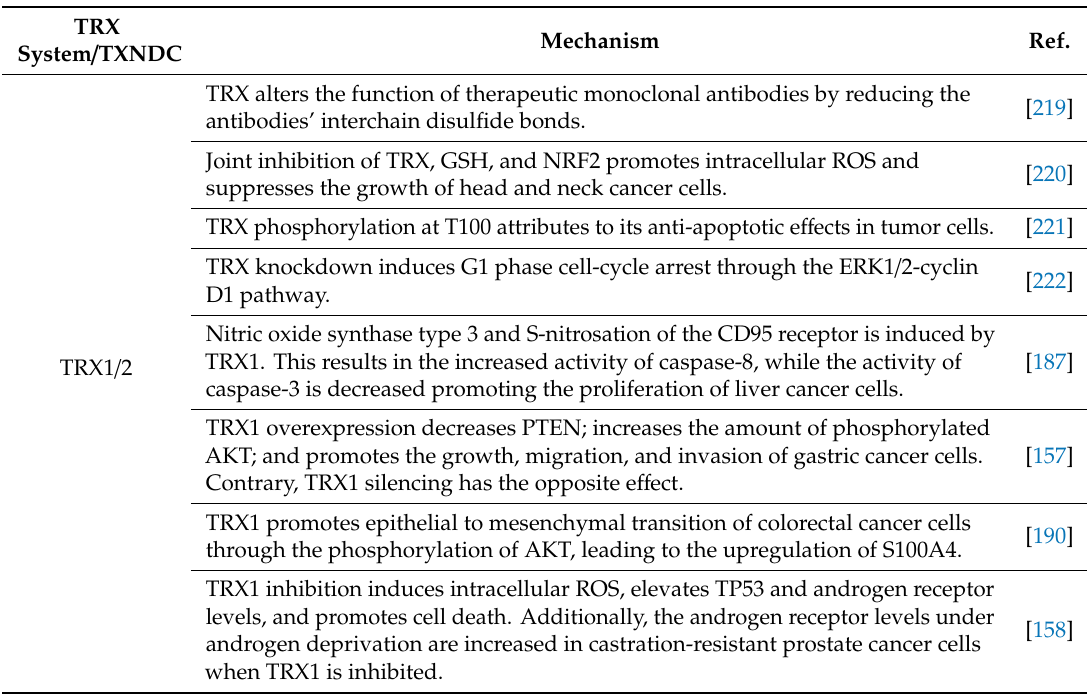
Table 3. Mechanisms of action of the TRX system or TXNDC protein family in